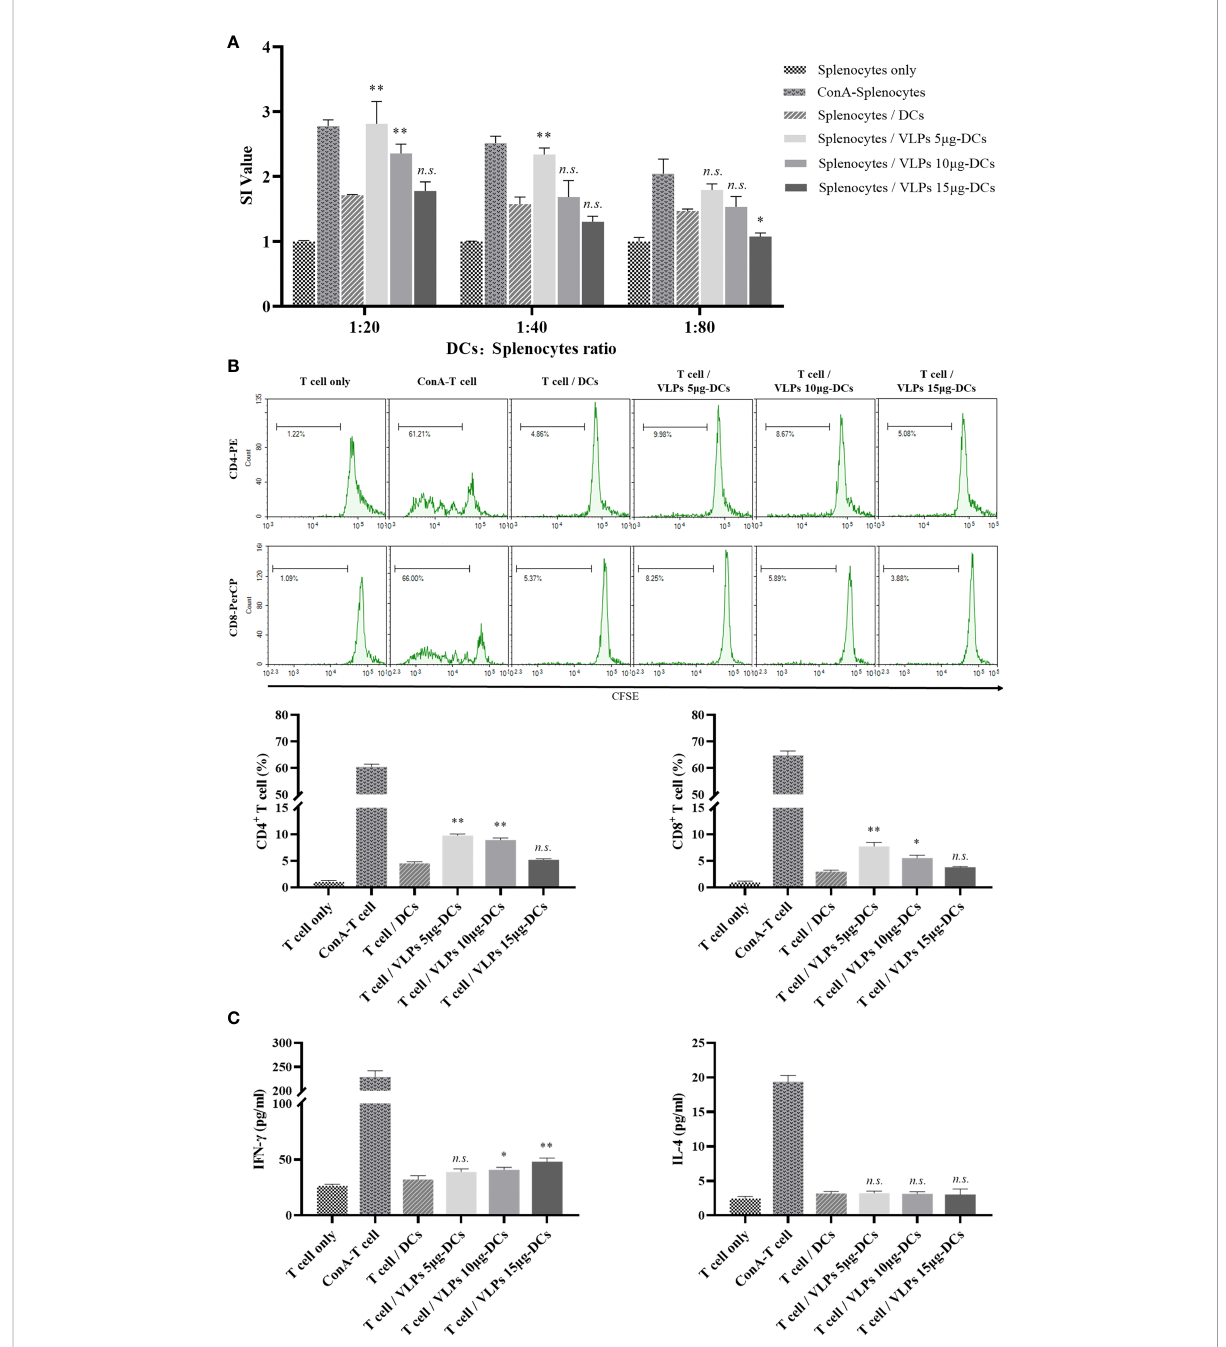
FIGURE 6 SARS-CoV-2 VLPs induce DCs to activate T cells ex vivo. (A) DCs were cultured with SARS-CoV-2 VLPs for 48 h and then cocultured with splenocytes at a ratio of 1:20, 1:40, and 1:80 for 72 h Splenocytes alone and splenocytes cocultured with untreated DCs served as controls, whereas concanavalin A (ConA)-treated splenocytes served as the positive control. The proliferation of splenocytes was measured using the CCK-8 kit. All data are the representative of three independent assays and expressed as mean ± SE; * P < 0.05 or ** <0.01 versus splenocytes cocultured with untreated DCs. n.s. not statistically signi fi cant. (B) Splenocytes were prestained with 5 m M CFSE and cocultured with SARS-CoV- 2 VLP-treated DCs at a ratio of 20:1 for 72 h The proliferation of CD4 + and CD8 + T cells in spleen cells were assessed via fl ow cytometry. All data are the representative of three independent assays and expressed as mean ± SE; * P < 0.05 or ** <0.01 versus T cells cocultured with untreated DCs. n.s. not statistically signi fi cant. (C) Culture supernatants obtained from experiments in B were harvested, and IFN- g and IL-4 were measured using ELISA. All data are the representative of three independent assays and expressed as mean ± SE; * P < 0.05 or ** <0.01 versus T cells cocultured with untreated DCs. n.s. not statistically signi fi